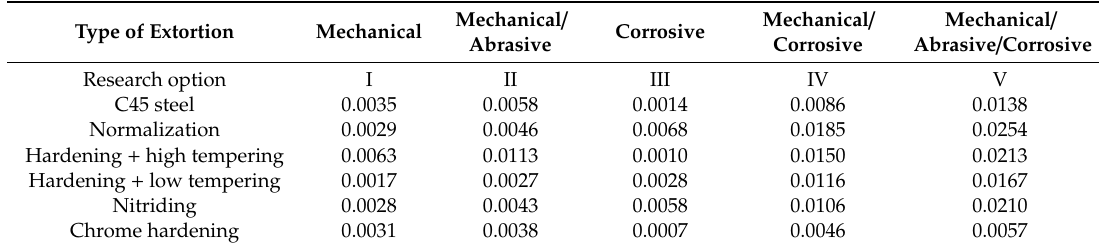
Table 11. Presentation of test results of wear of samples in all analyzed options of the experiment g [40].